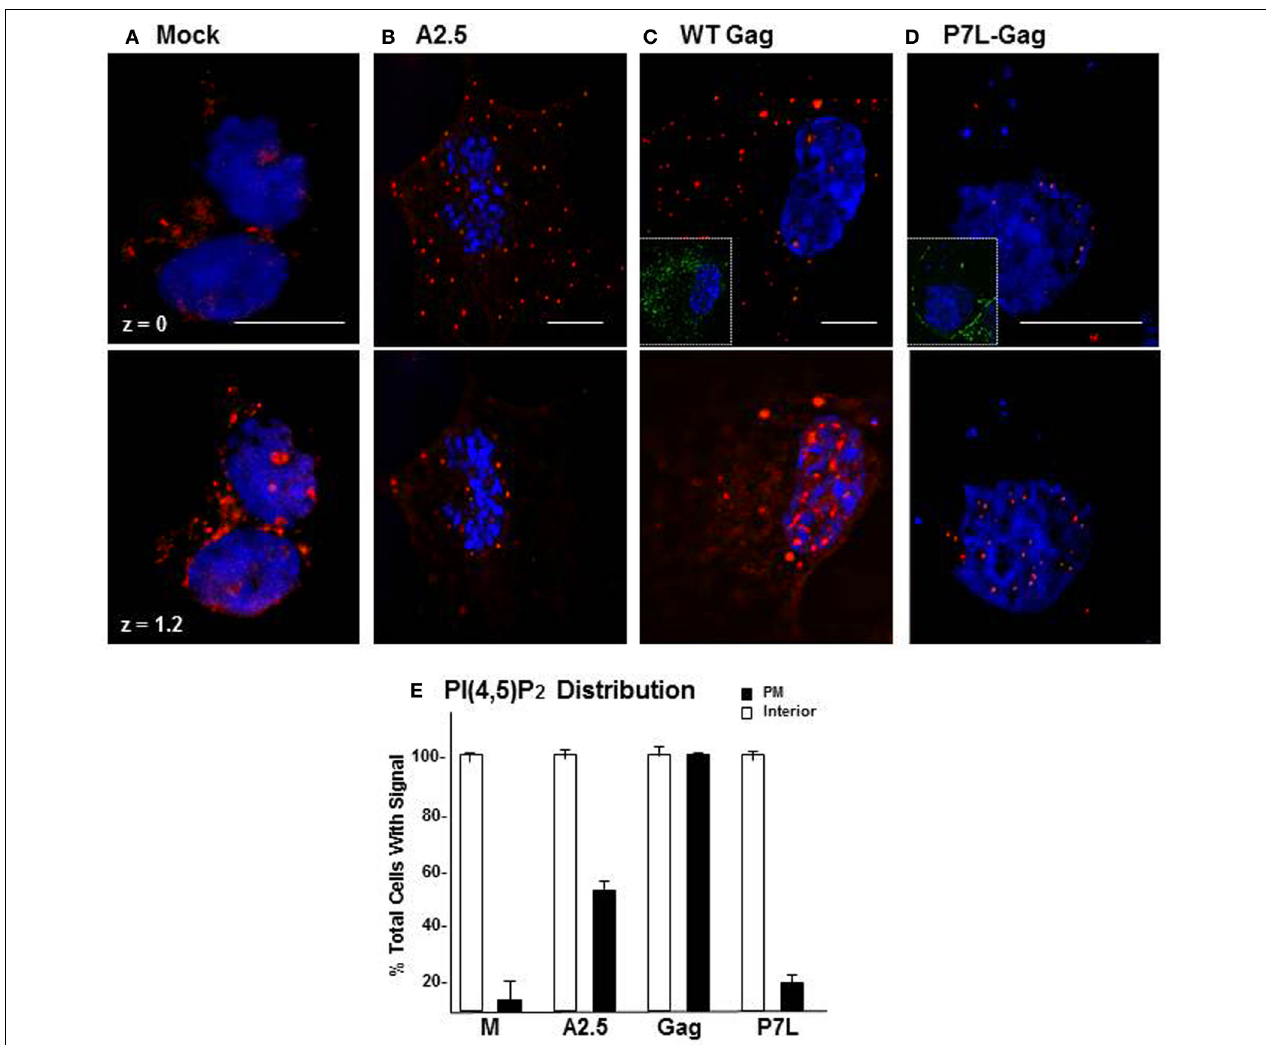
visualized by indirect immunofluorescence using a TRITC-labeled secondary antibody ( red ) targeted to the primary antibody. Insets in (C,D) show Gag expression in the cells as detected using primary antibody that recognized the capsid domain in Gag and a FITC-labeled secondary antibody targeted to the primary. The bar measures 10 μ m. (E) Distribution of PI(4,5)P2 in